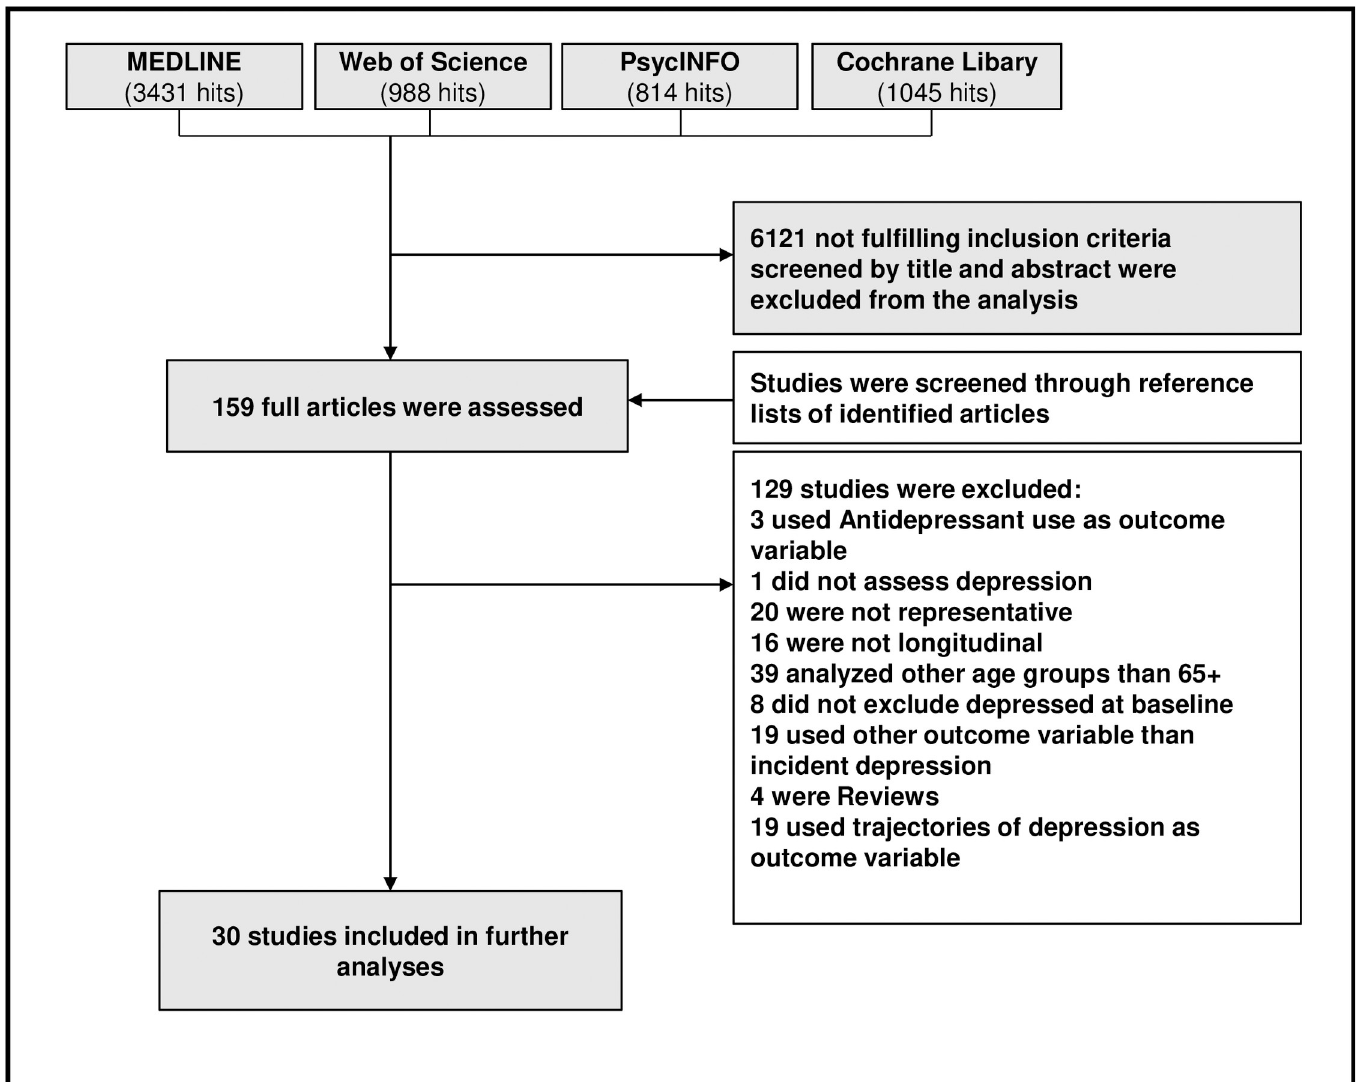
Fig 2. Results of the systematic literature